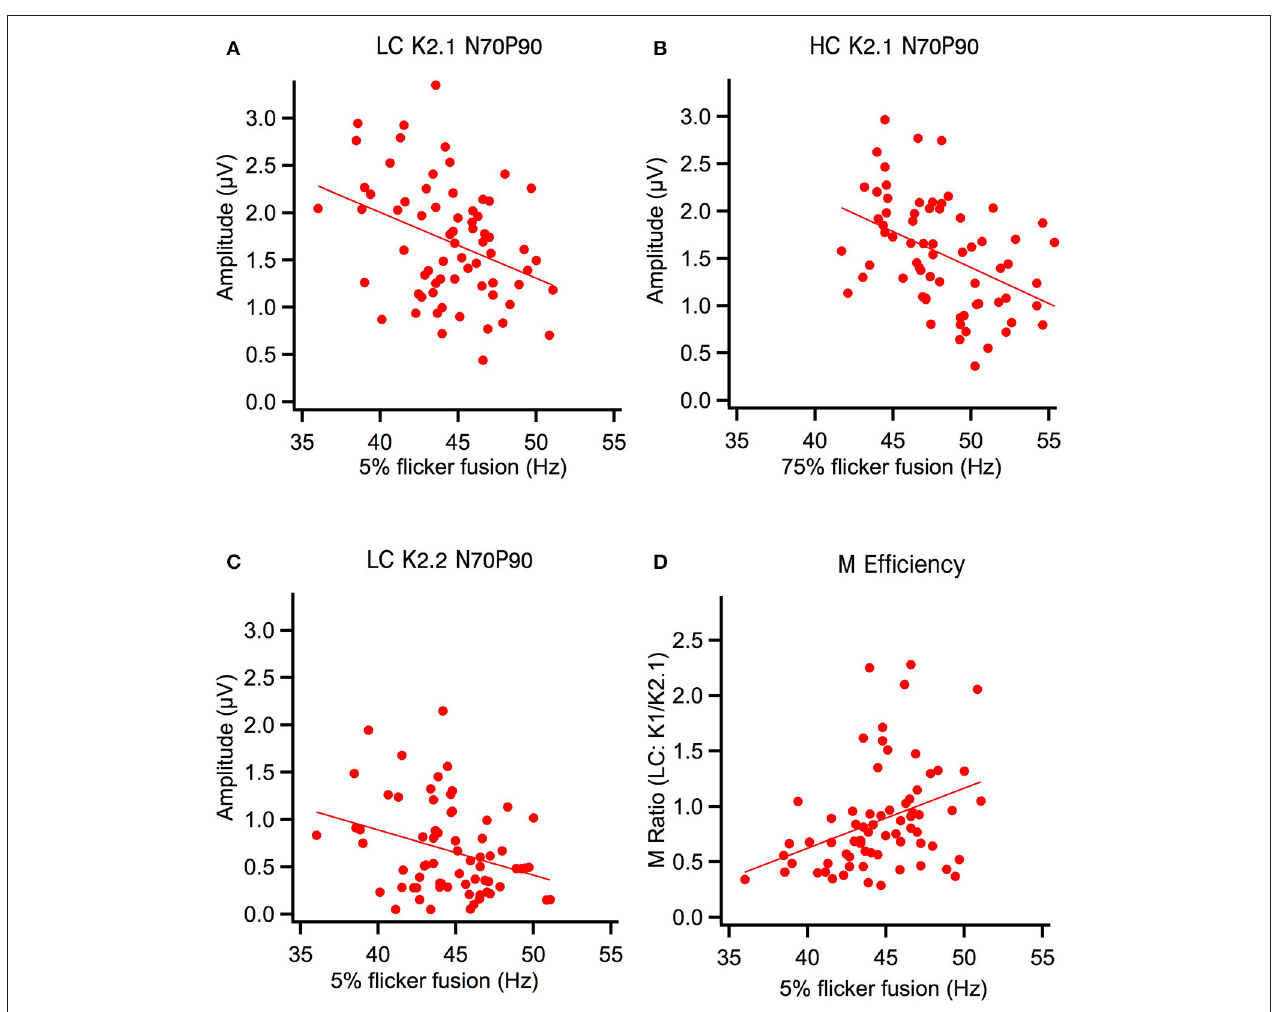
FIGURE 3 | Flicker fusion at high and low contrast (HC, LC) correlated negatively with early second order amplitude components and positively with the M ratio. (A) Low contrast K2.1 N70 − P100 amplitude component was significantly correlated with low contrast flicker and (B) high contrast K2.1 N70 − P100 amplitude component was significantly correlated with high contrast flicker. (C) At low contrast the K2.2 N70 − P100 amplitude component was also significantly correlated with low contrast flicker. (D) Magnocellular efficiency increases as a function of low contrast flicker fusion